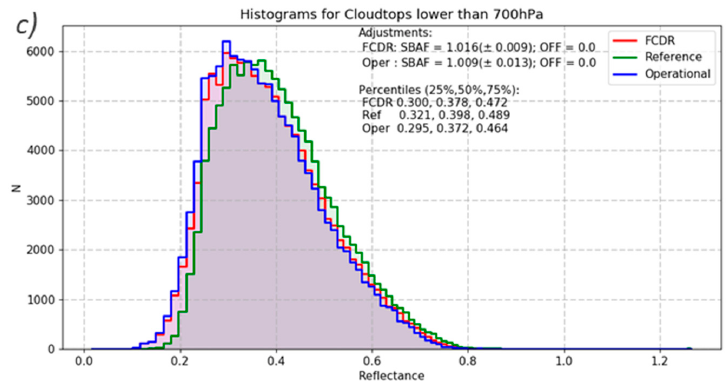
Figure 14. Histogram of SEVIRI HRVIS plotted as reference together with the histograms of the operational MVIRI dataset and the recalibrated MVIRI FCDR, as obtained from entirely cloud-covered pixels at 12:00 UTC slots during March 2005. Clouds are classified into high clouds ( a ), middle clouds ( b ) and low clouds ( c ). The MVIRI datasets were band adjusted to the SRF of the SEVIRI HRVIS band according to the given SBAFs. For each cloud-class the SBAFs for the operational dataset and for the FCDR are computed on the same set of SCIAMACHY spectra and the di ff erence between both SBAFs is entirely due to the di ff erent shapes of the SRFs in the operational dataset and the FCDR.